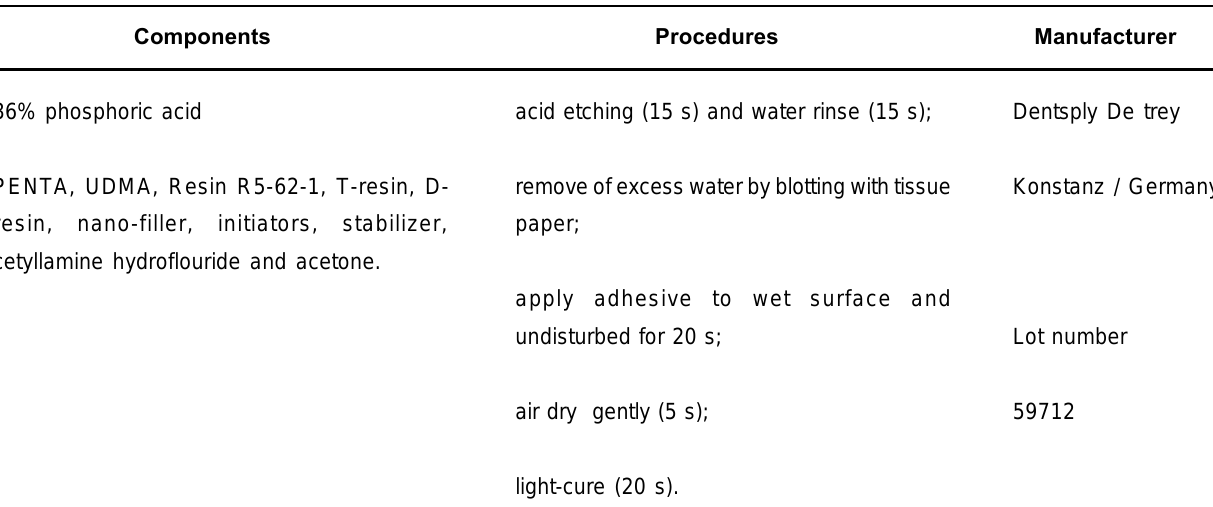
TABLE 1 - Components of Prime & Bond NT one bottle adhesive system used and procedures for